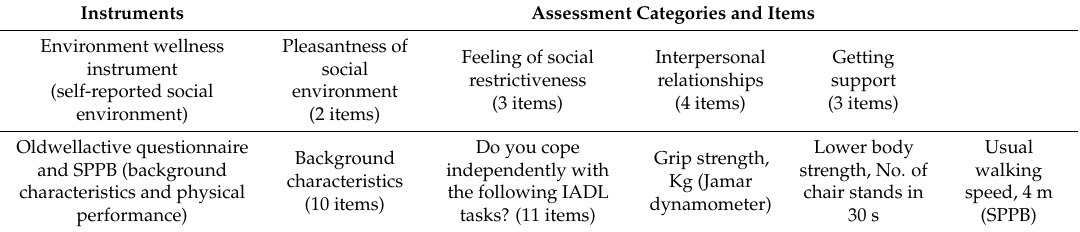
Table 1. The modified instruments used to measure participants background characteristics, perception for their social environment and physical performance 3 and 12 months after relocation to senior housing.